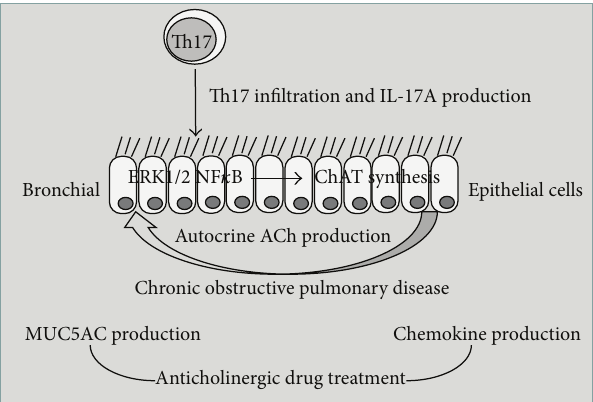
Figure 10: Autocrine acetylcholine induced by IL-17A, via NF 𝜅 B and ERK1/2 pathway activation, promotes MUC5AC and IL-8